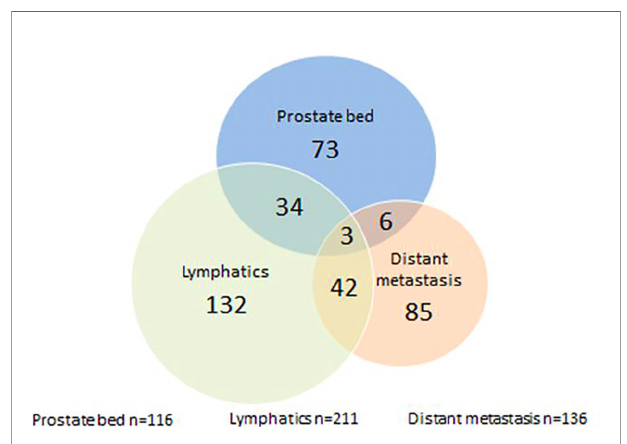
FIGURE 2 | Pre-radiotherapy PSMA-PET/CT fi ndings; n = 394.